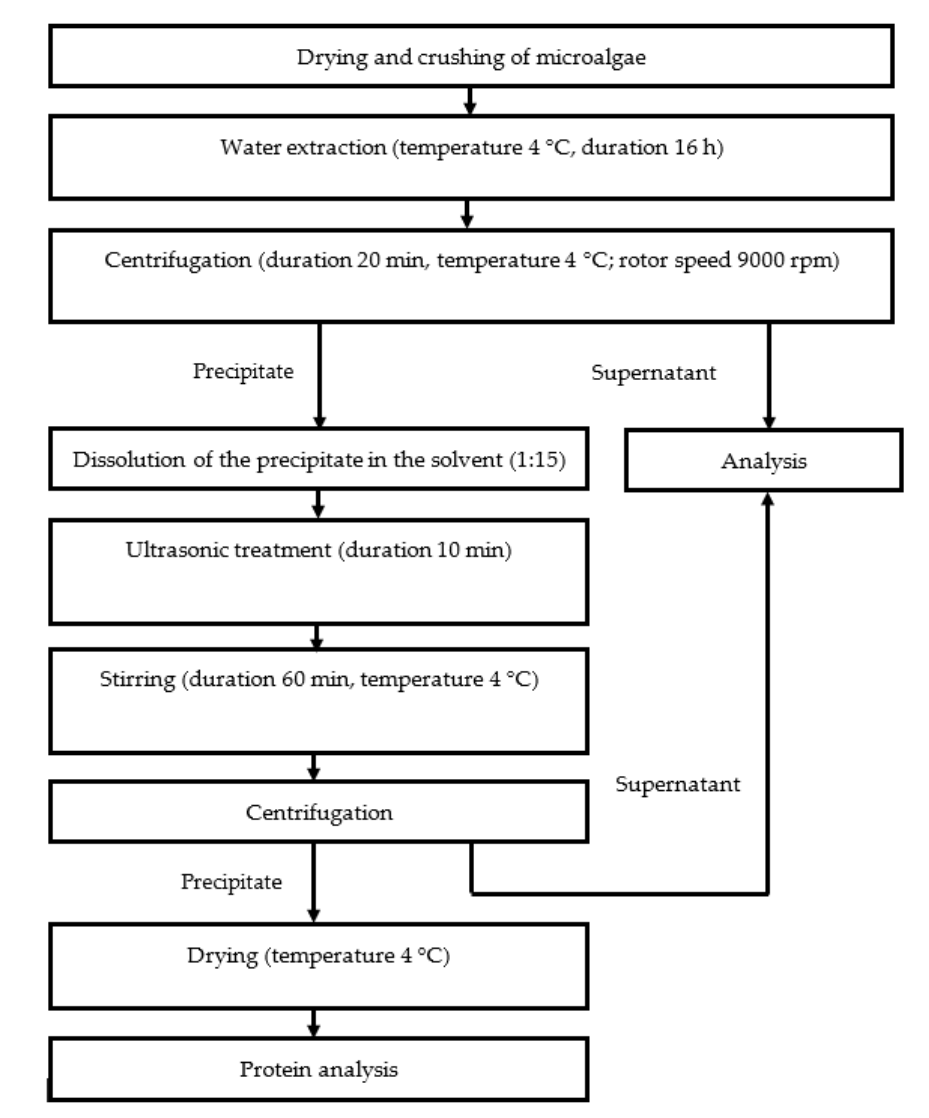
Figure 1. Protein extraction flowchart.